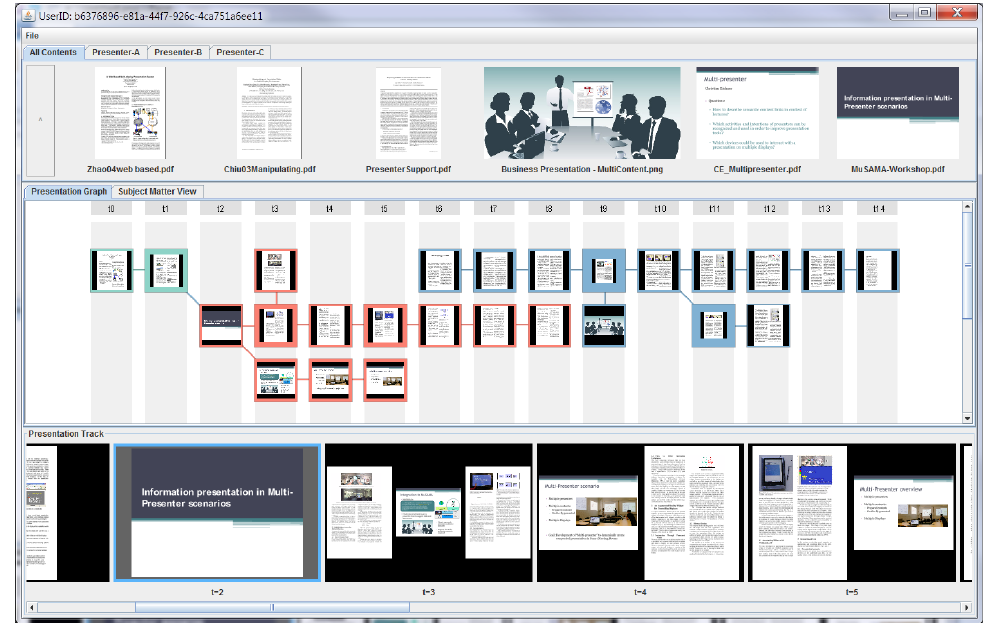
Figure 1. Screenshot of the user interface. The content pool is represented at the top. Participants can publish contents by dragging them into this region. The relation between content parts is depicted at the center of the screen. By drag and drop, participants can put content parts from the content pool into this region and link them via connector lines. Content parts of different participants are distinguished by color. The layers are shown at the bottom. Contents of this layer are successively shown on the available displays. The current layer is highlighted by a blue